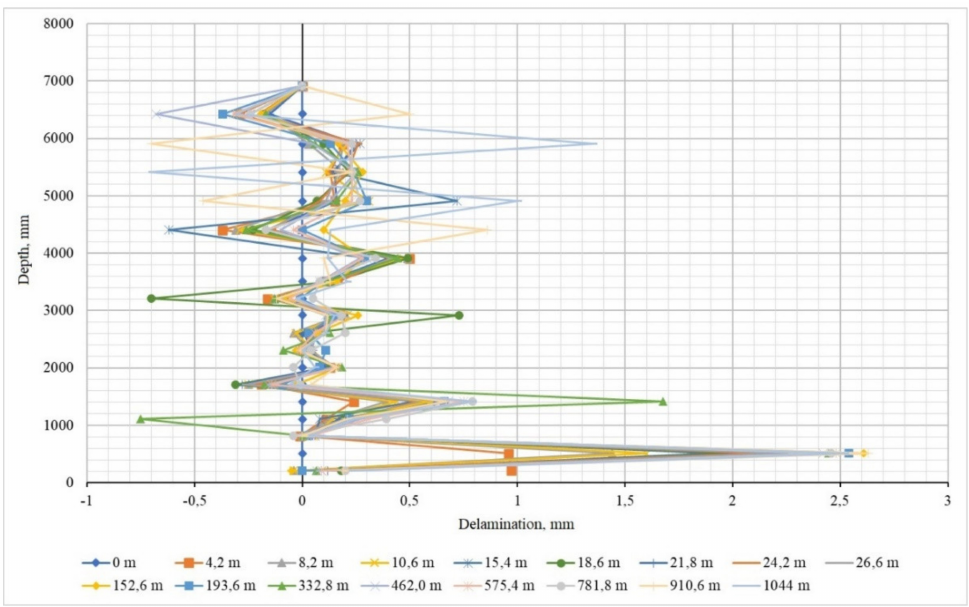
Figure 10. Roof delaminations measured using extensometric probe–periodic control station no. 1.